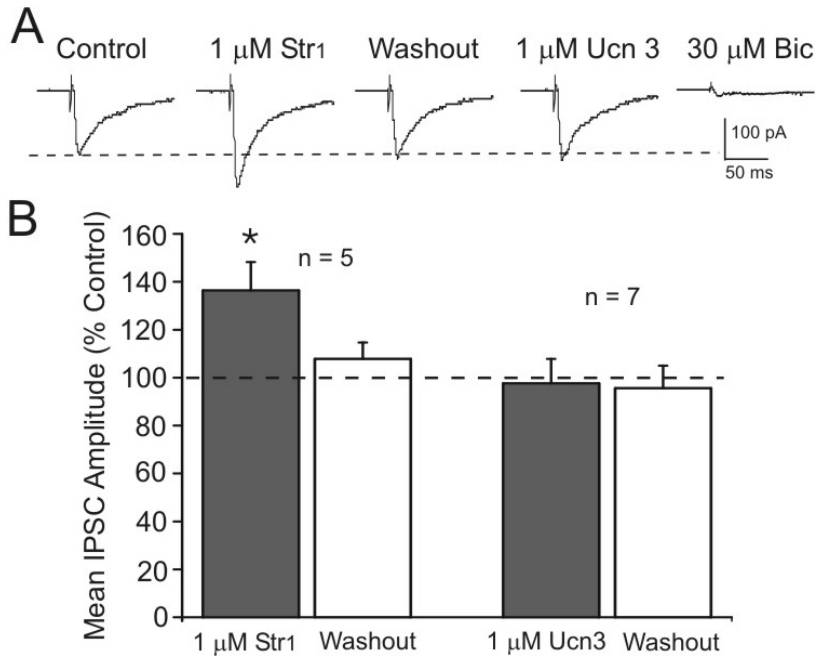
FIGURE 3. Stressin 1 , but not Ucn 3, augments evoked GABAergic IPSCs in CeA neurons from WT mice. (A) Representative current traces of evoked IPSCs from a CeA neuron. Superfusion of 1 µ M stressin 1 (Str 1 , a selective CRF 1 agonist) increases the amplitude of evoked GABAergic IPSCs in this CeA neuron, with recovery to control levels on washout. In the same neuron, superfusion of 1 µ M Ucn 3 (a selective CRF 2 agonist) has no effect on the IPSCs. Subsequent bicuculline (Bic; 30 µ M ) superfusion totally blocked the IPSCs, indicating that they were mediated by GABA A receptors. (B) Pooled data: 1 µ M stressin 1 significantly ( p < 0.05) increased the mean amplitudes of evoked GABA A ergic IPSCs in five CeA neurons from WT mice, with recovery to control levels on washout. However, 1 µ M Ucn 3 had no significant effect on mean evoked IPSCs in seven CeA neurons from WT mice. * = p <